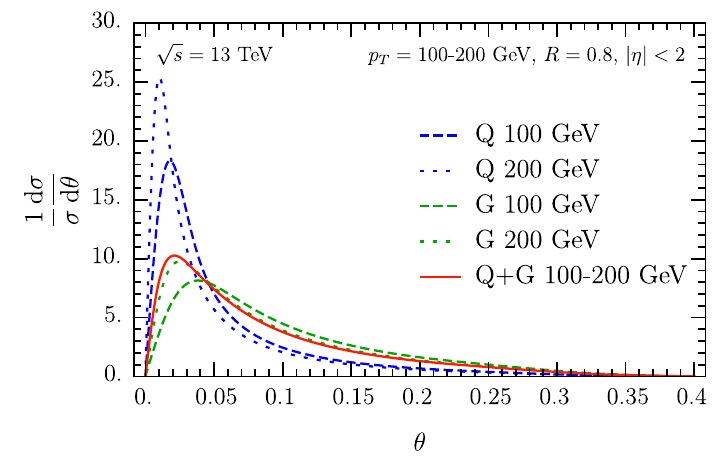
Figure 9 . Quark (blue) and gluon (red) distributions for the angle between the standard and the WTA axis for p T = 100 GeV (dashed) and 200 GeV (dotted). The solid line shows the p T integrated result summed over quarks and gluons which corresponds to the central curve in the upper right panel of (cid:12)gure 7.